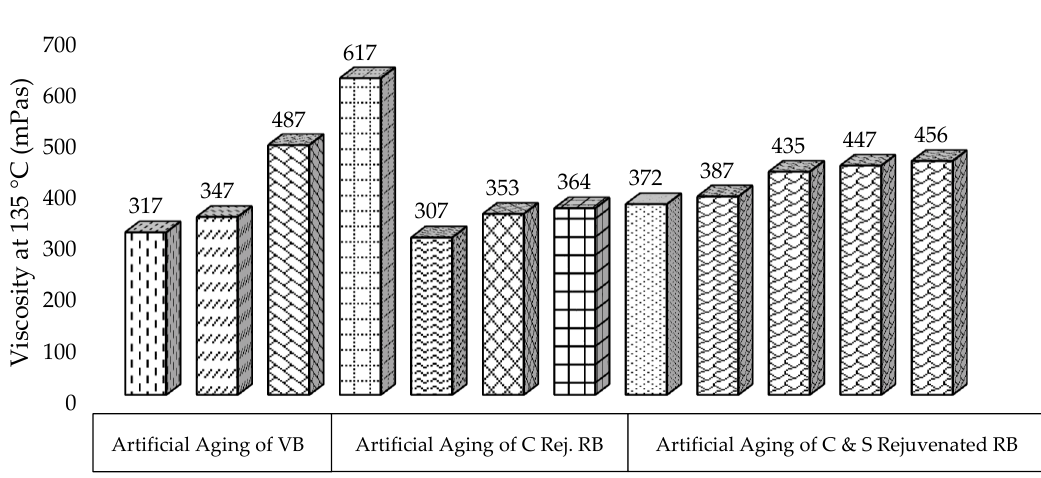
Figure 5. Effect of rejuvenation and aging on the viscosity of binders.